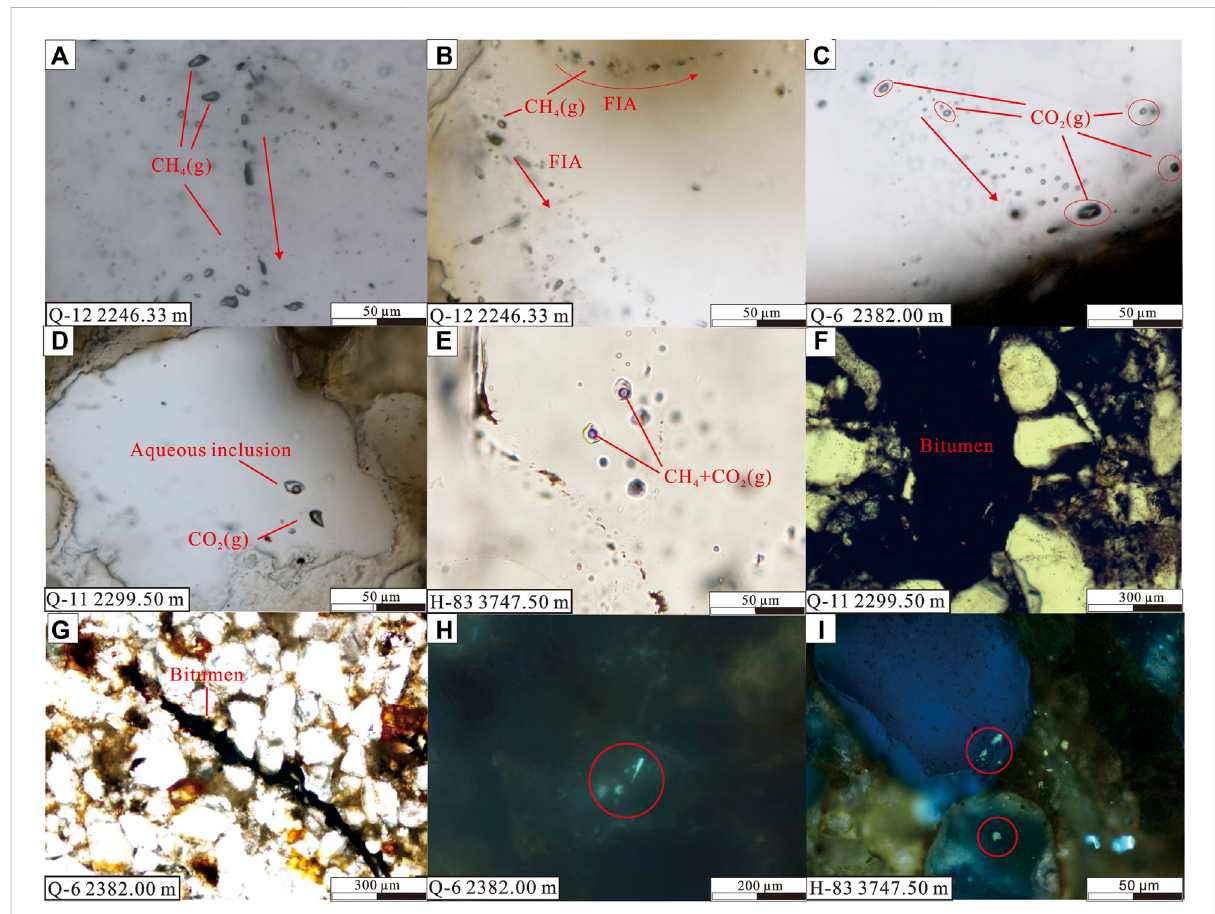
FIGURE 5 Typical microphotographs of fl uid inclusions in the western slope belt of Dongpu Sag: (A,B) single-gas phase inclusions distributed along microfractures or in quartz grains; (C,D) CO 2 gaseous inclusions arranged in the same direction in microfractures or coexisting with dissolved CO 2 aqueous inclusions in quartz; (E) CH 4 and CO 2 dissolved aqueous inclusions exist in quartz; (F,G) bitumen as band shapes exist in pores of mineral grains; (H) blue-green fl uorescent liquid hydrocarbon inclusions are located inside quartz particles; (I) yellow fl uorescent liquid hydrocarbon inclusions are located in the interior of quartz overgrowths. Component identi fi cation of gas inclusions based on Raman spectroscopy qualitative